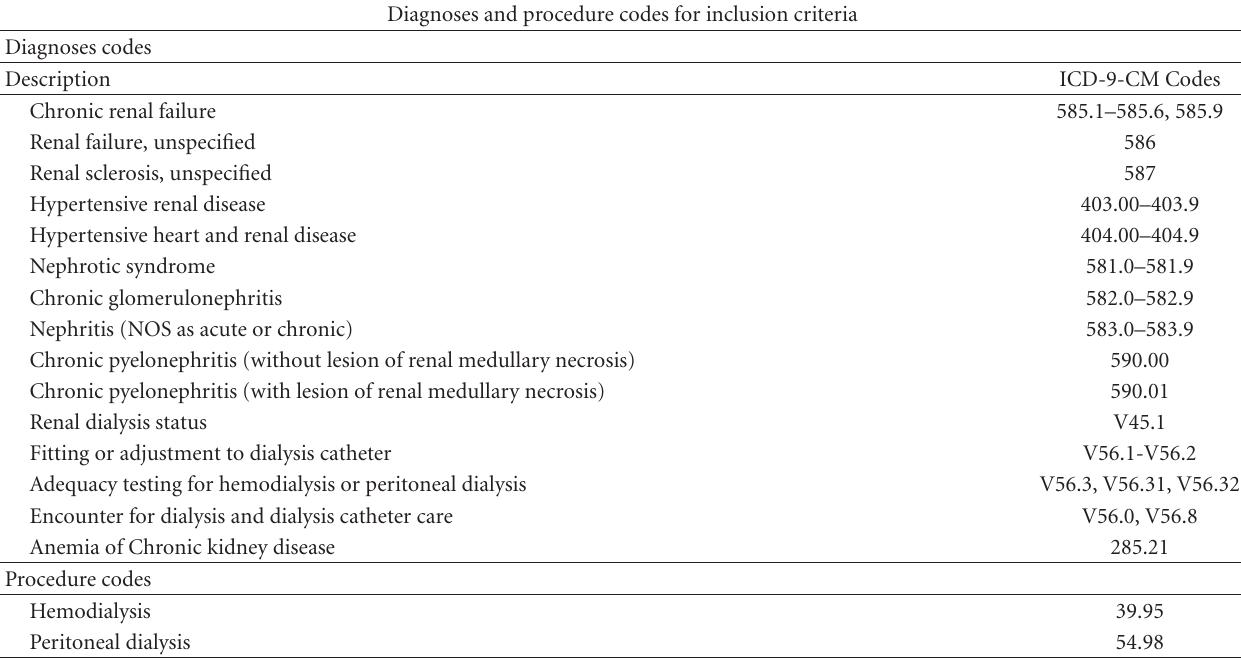
Table 1: Diagnoses codes (ICD-9-CM) and procedure codes used to identify Chronic Kidney Disease patients (inclusion criteria). Diagnoses and procedure codes for inclusion criteria